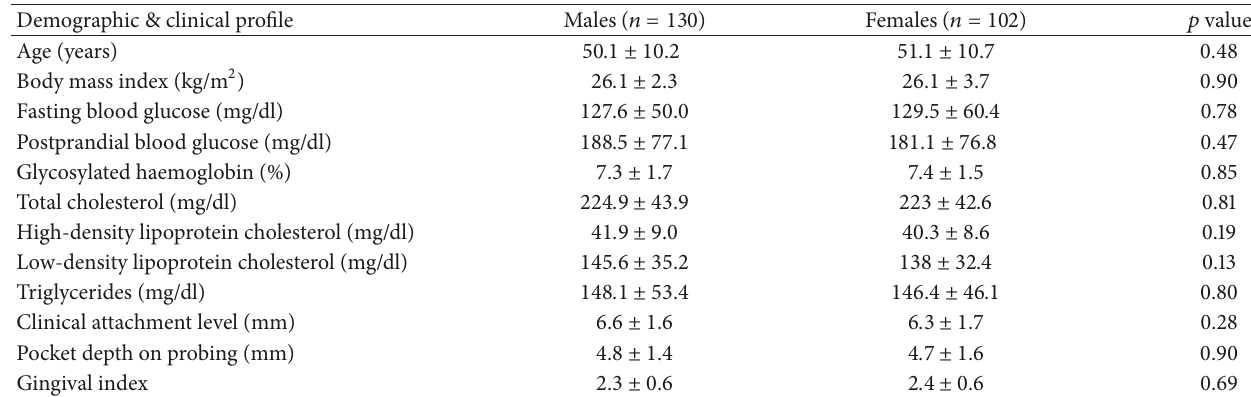
Table 2: Descriptive statistics across gender.